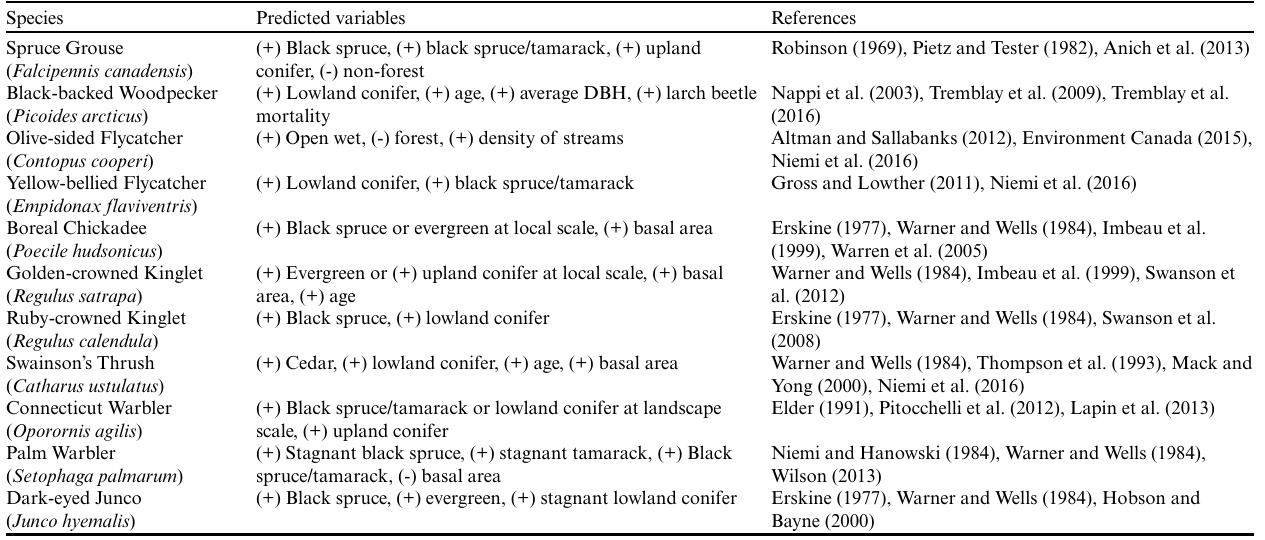
Table 2 . Landscape and forest stand variables (Table 1) predicted to affect bird species’ distributions within the Agassiz Lowland Subsection. The predicted effect of each variable on the species’ distribution is indicated as either positive (+) or negative (-) and supporting references are cited.